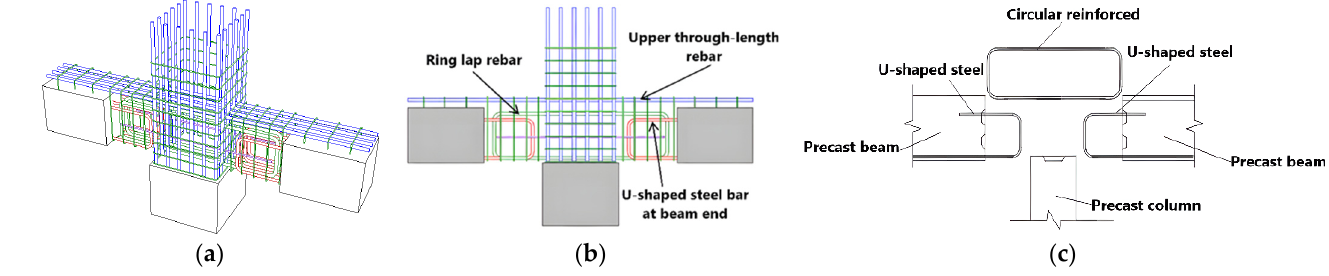
Figure 4. Schematic diagram of ring-buckle connection: ( a ) 3D view of the beam-column connection; ( b ) Front view of the beam-column connection; ( c ) Schematic diagram of ring reinforcement draw- down.